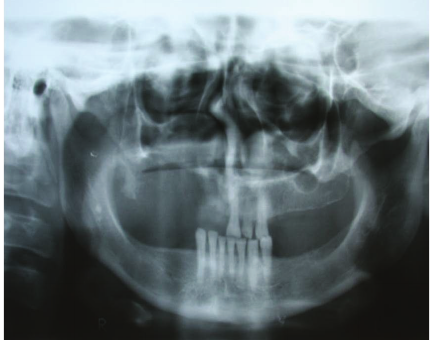
Figure 3: Panoramic radiography.